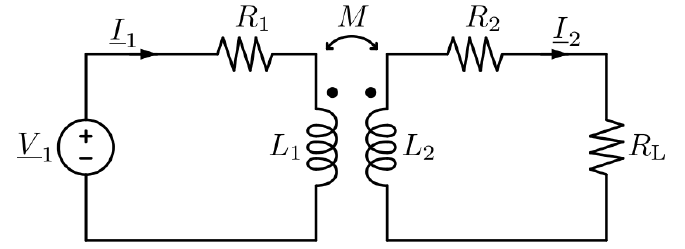
Figure 1. Circuit model of two coupled inductors with the sinusoidal voltage source of amplitude V 1 and the equivalent load R L